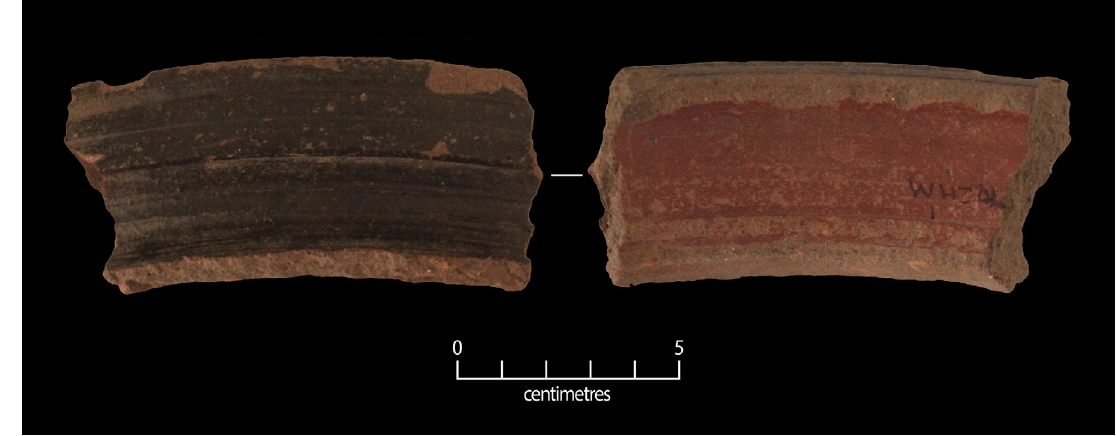
Figure 17: External and internal surfaces of a Class 5 variant 3